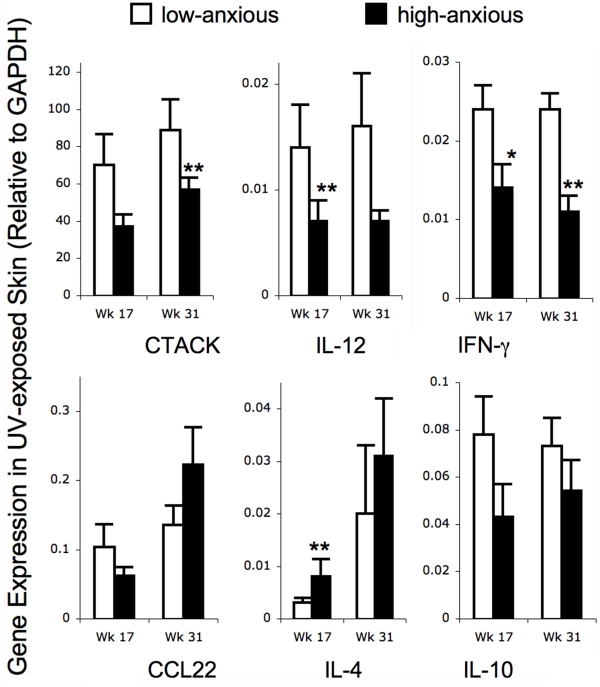
Effects of anxiety phenotype on chemokine and cytokine gene expression in UV-exposed skin.Gene expression in dorsal skin was measured by quantitative PCR at weeks 17 and 31 in low- (white bars) and high- (black bars) anxiety mice. mRNA levels of chemokines and cytokines known to be protective (CTACK, IL-12, and IFN-γ) or harmful (IL-4 and IL-10) in the context of SCC were quantified. Levels of mRNA expression normalized to glyceraldehyde-3-phosphate dehydrogenase (GAPDH) mRNA are shown. Data are expressed as mean ± SEM. Outcomes were optimally Box-Cox transformed prior to analysis. For each outcome, means were compared between groups using a two-sample t-test with Satterthwaite adjustment for unequal variances. Statistical trends (* p < 0.09) and significant differences (** p < 0.05) are indicated, and corresponding effect sizes are mentioned in the text. For all comparisons where the t-test showed a statistical trend, regression analysis showed statistical significance, the only exception being week 17 IFN-γ gene expression.